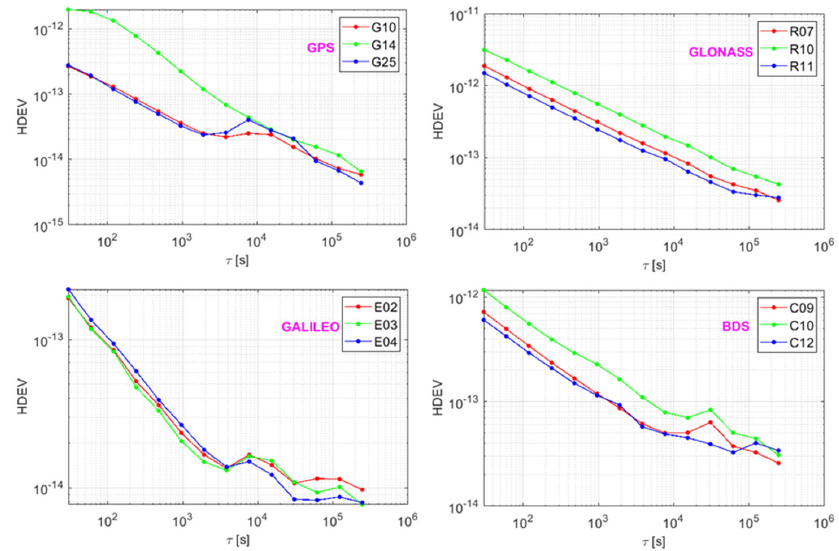
Figure 4. Stability of GNSS satellite clock ( a ) GPS, ( b ) GLONASS, ( c ) GALILEO, ( d ) BDS.